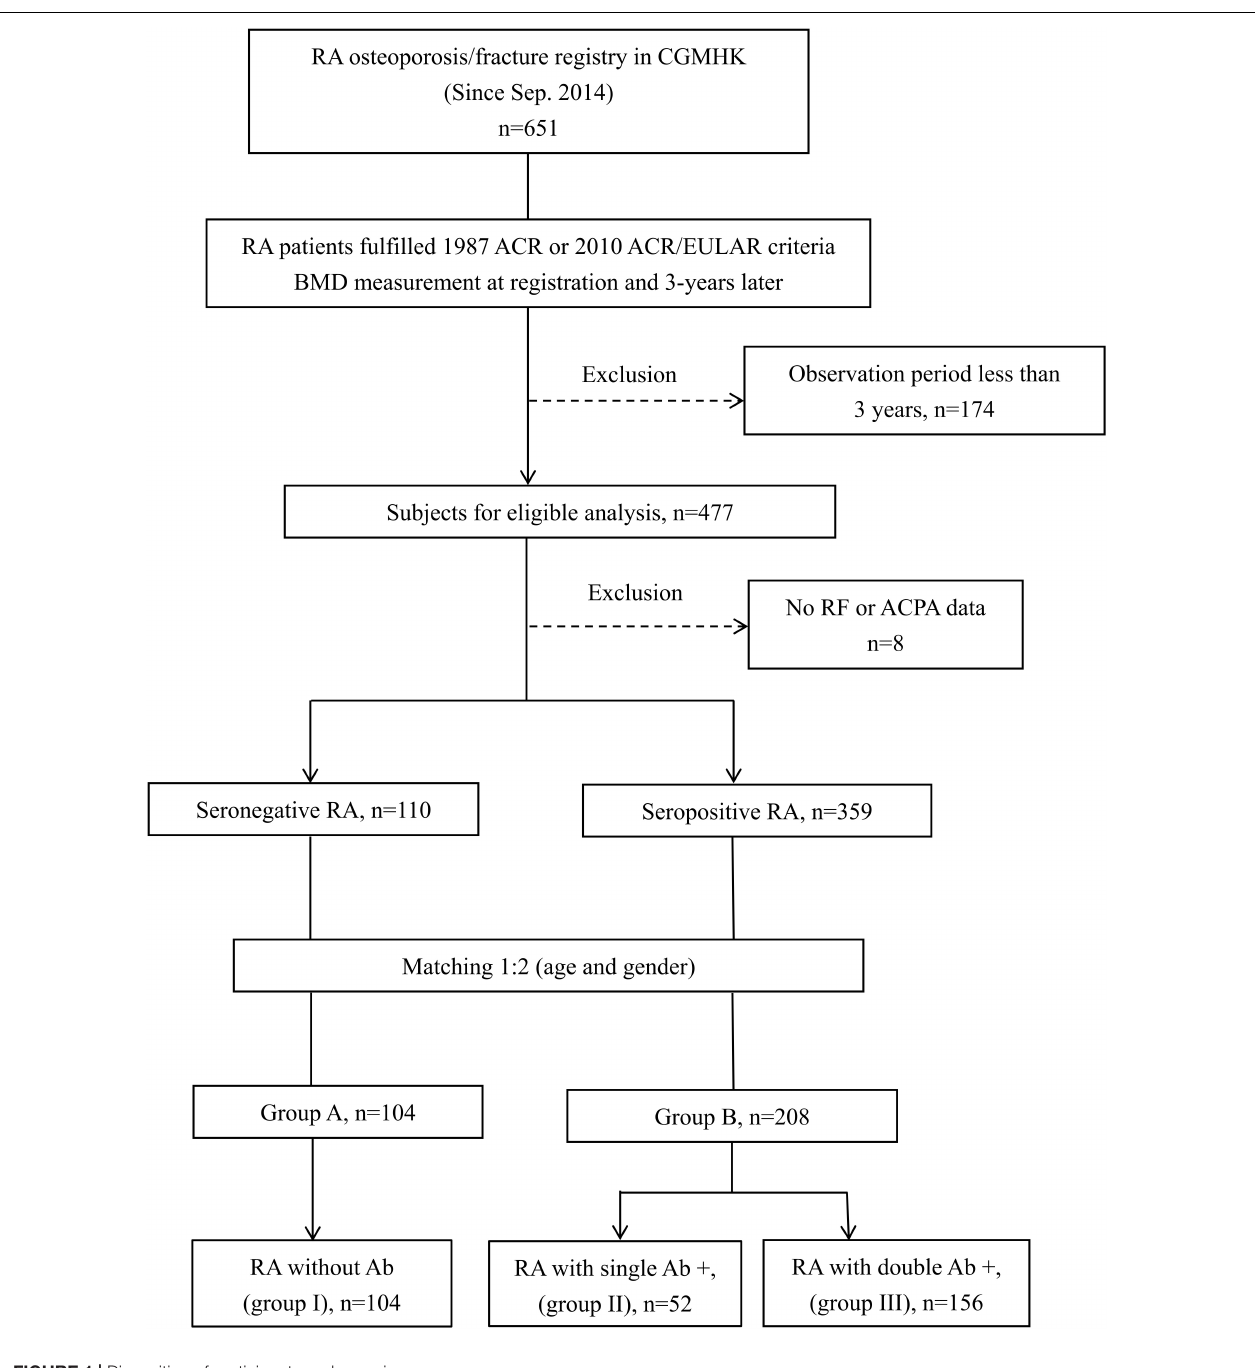
FIGURE 1 | Disposition of participants and